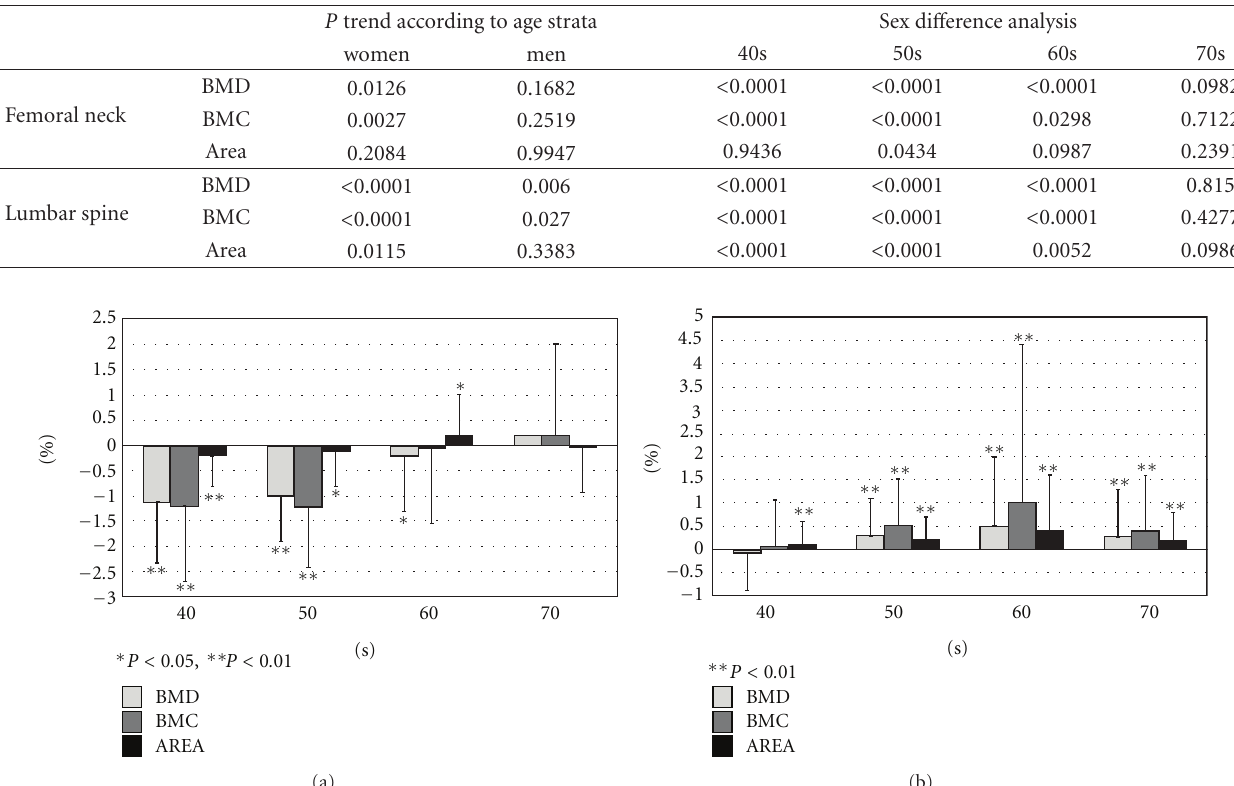
Table 2: P trend according to age strata and P value of sex di ff erence analyses of subgroup.